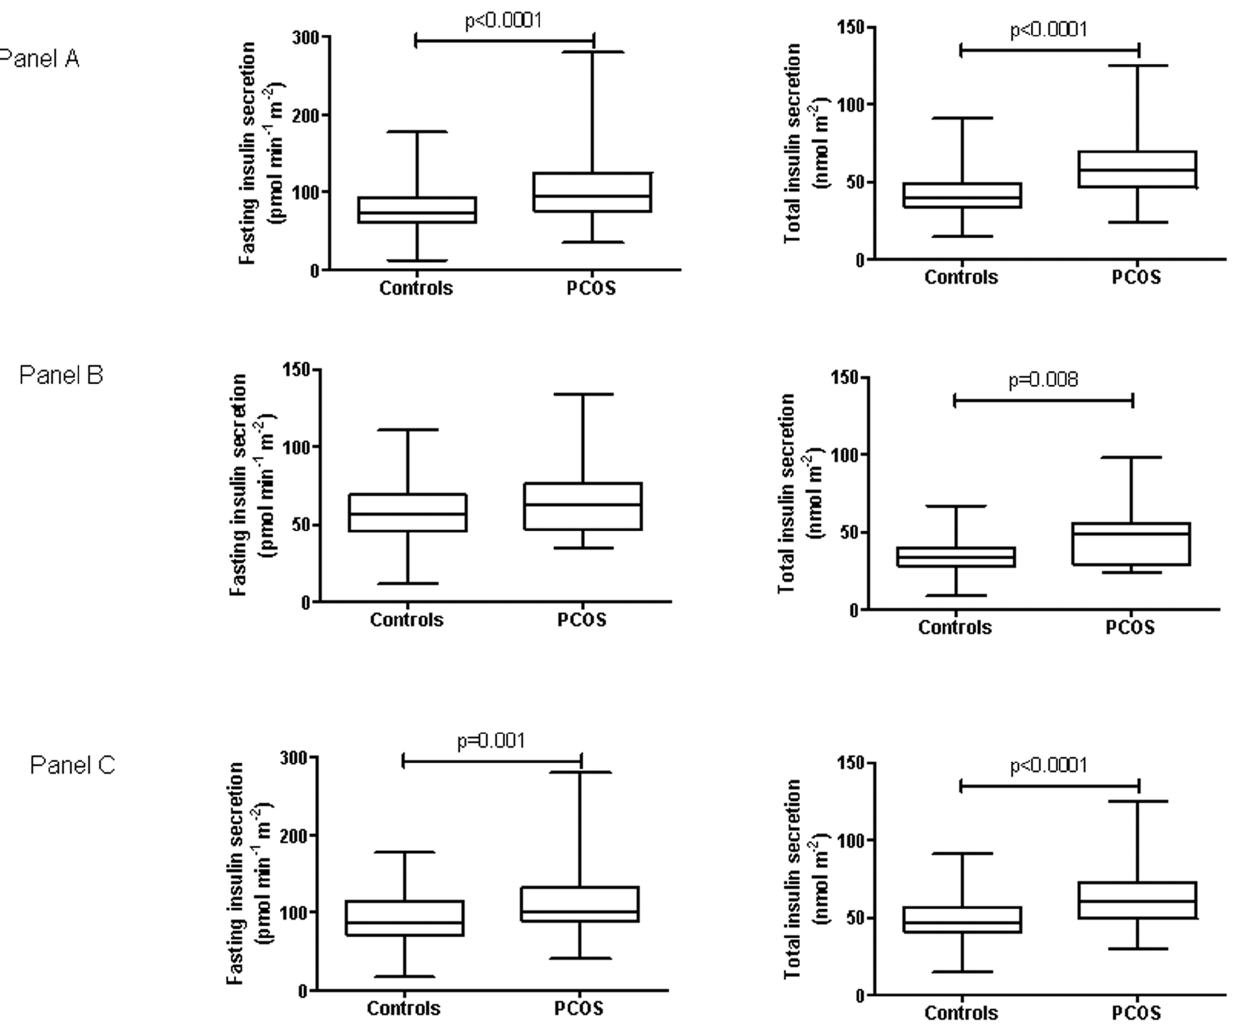
Figure 2. Insulin secretion in insulin sensitive and resistant cases and controls. Fasting and total insulin secretion (box and whiskers, min to max) in control and PCOS women having insulin resistance defined as HOMA-IR $ 1.26 (panel A); insulin sensitivity defined as WBISI $ 7.91 (panel B) and insulin resistance as WBISI , 7.91 (panel C).